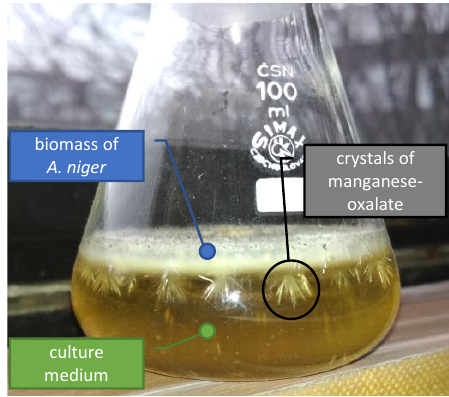
Figure 9. The biogenic manganese oxalate crystals associated with the fungal biomass of filamentous fungus Aspergillus niger cultivated in the presence of Mn(IV)-oxide.